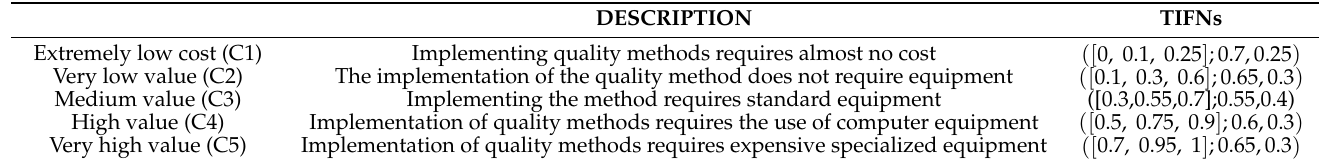
Table 3. Implementation